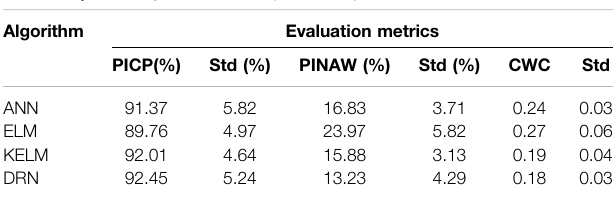
TABLE 2 | Summary of the interval prediction performance.